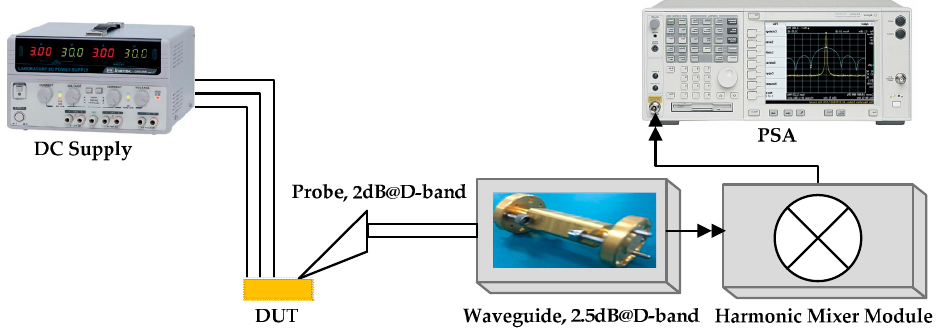
Figure 12. The measurement setup for VCO.